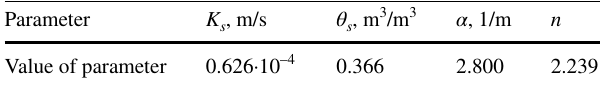
Table 2 Hydraulic parameters of sandy soil assumed in the basic model as natural soil (Kirkland et al. 1992) Parameter K s ,